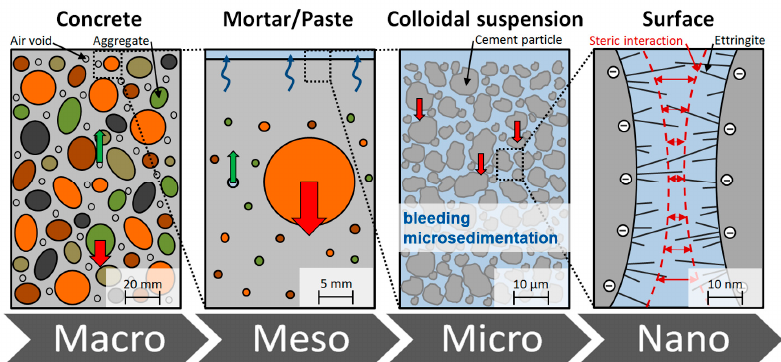
Figure 1. Illustration of concrete segregation phenomena on all scale levels of concrete, based on [2].